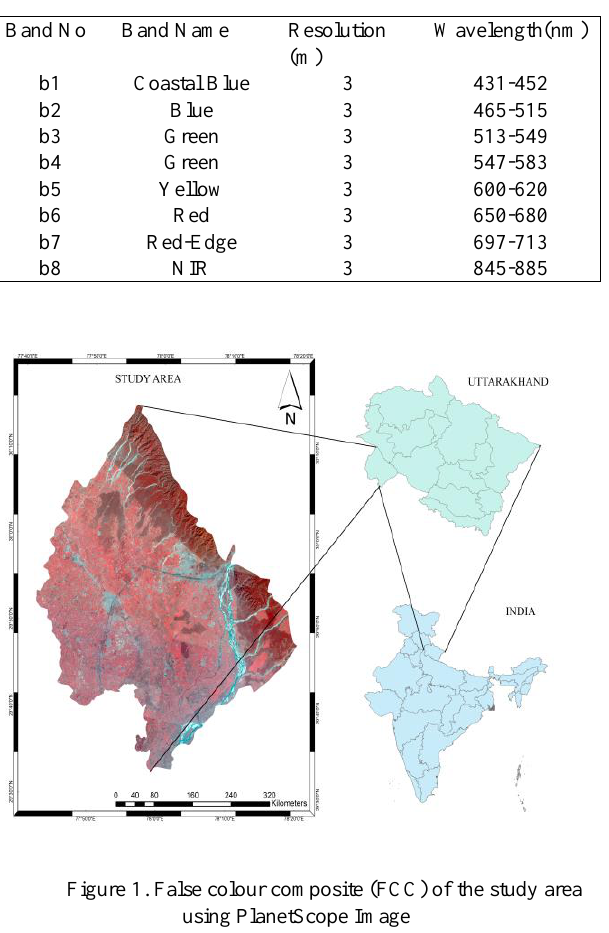
Table 1. PlanetScope 8 Band Dataset Detailed Specification